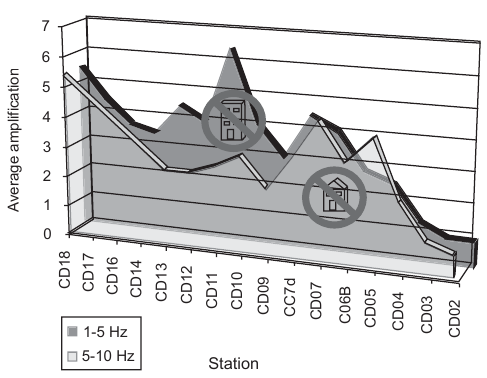
Fig. 9 . Amplification values in the frequency band 1-5 Hz, 5-10 Hz at the sites along the EW transect. Our results suggest a potential hazard maximum in the center of the basin for 2-3 storey buildings, and at the edges for 1 storey